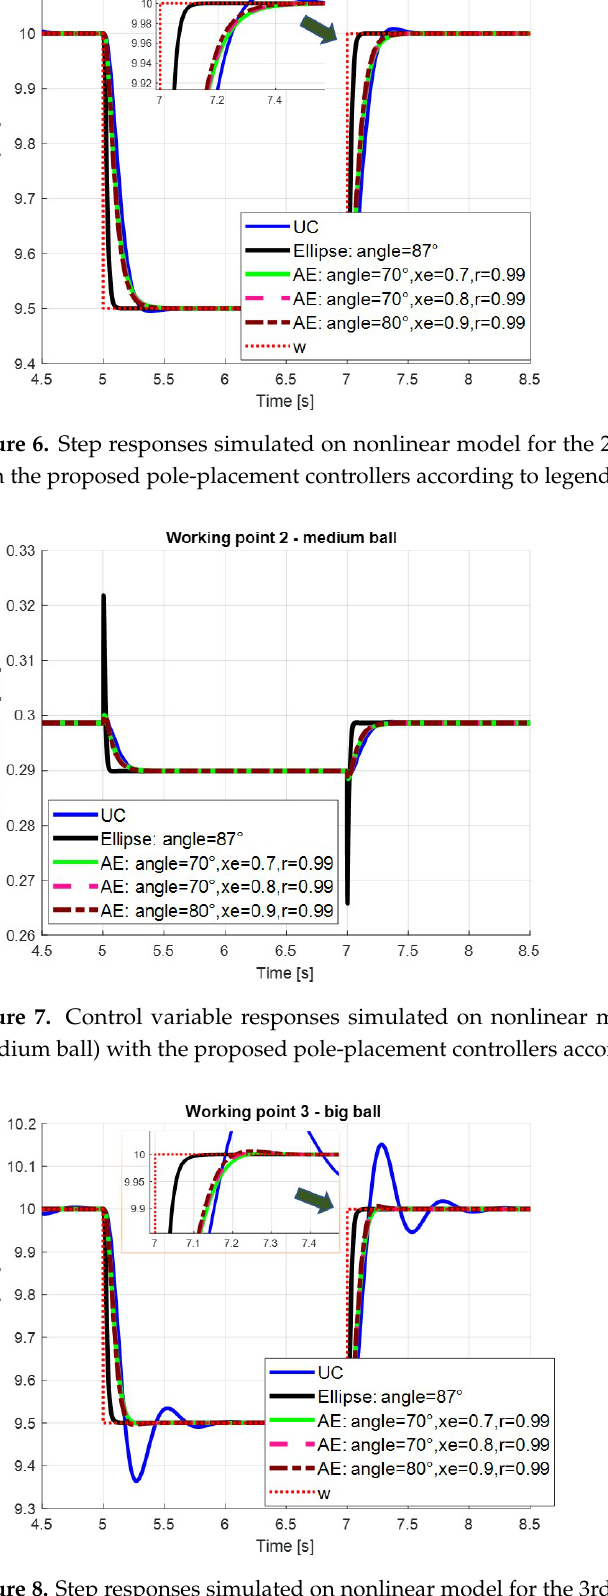
Figure 8. Step responses simulated on nonlinear model for the 3rd working point (big ball) with the proposed pole-placement controllers according to